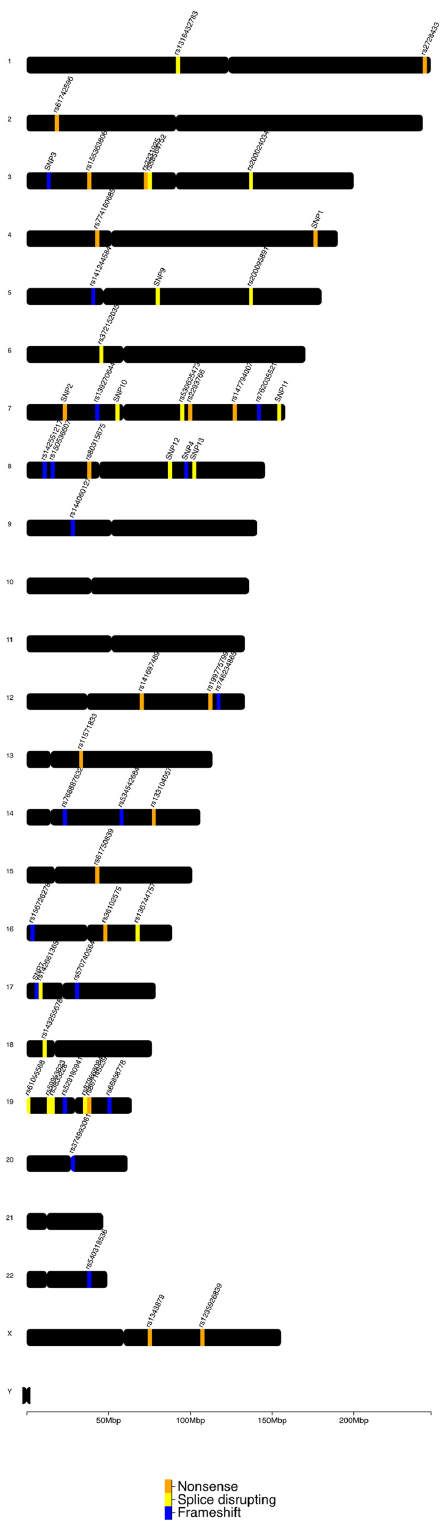
Figure 2. Prioritized high impact variants found on teratozoospermic individuals based on their genomic location (whole-genome representation). Nonsense (orange), splice-disrupting (yellow), and frameshift variants (blue) are distinguished by color as presented. The figure was created with chromoMap